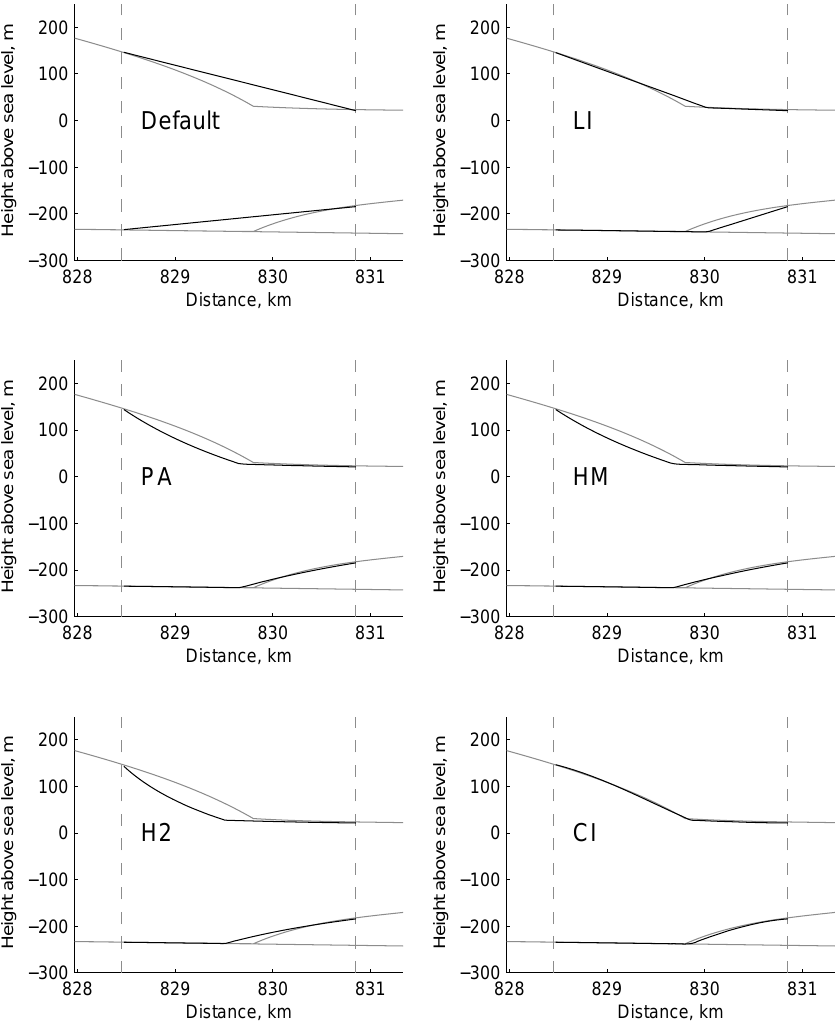
Fig. 1. Example illustration of the different thickness interpolation functions used in the grounding line parameterisations. The solid grey lines show the ice sheet profile (bedrock, lower ice surface and upper ice surface from bottom upwards) from a snapshot during the evolution of a very high resolution simulation ( 1x = 0 . 15km). The black lines show each of the different thickness profiles (Sect. 3) at lower resolution ( 1x = 2 . 4km) for the case where the high resolution simulated grounding line position lies near the centre of the lower resolution grid box. Low resolution grid point positions are shown with vertical grey dashed lines. The LE profile is not shown as it defaults to LI in this case. The default profile corresponds to no parameterisation - the grounding line is assumed to rest at the last grounded grid point.